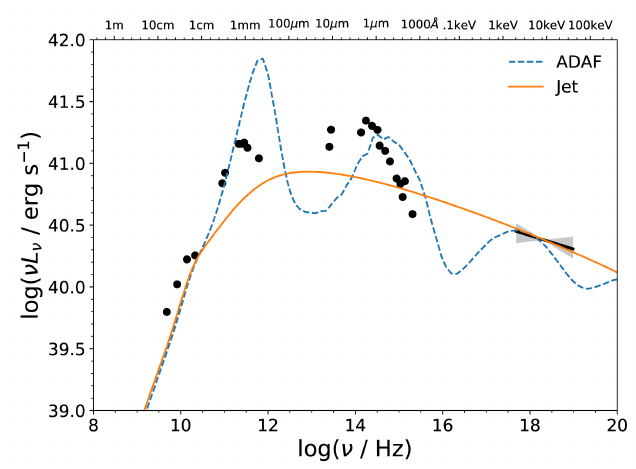
Figure 3. SED of the M87 core with X-ray data taken from Wong et al. [13] (grey: 90% confidence region in photon index) and the rest taken from the 0. (cid:48)(cid:48) 4 quiescent data of Prieto et al. [16]. The ADAF and jet models were renormalized to match in X-rays. These figure is reproduced from Wong et al.